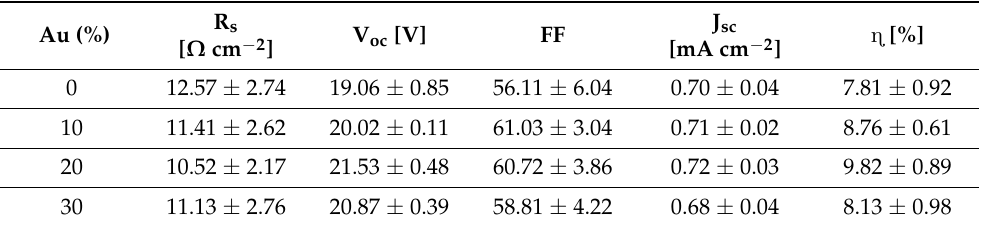
Figure 14. ( a ) J – V characteristics for devices with and without doping of Au-NPs in the HTLs; ( b ) IPCE curves for devices with and without doping of Au-NPs in the HTLs. Reproduced with permission from Ref. [115]. Table 8. With and without HTL doping with Au-NPs under STC.